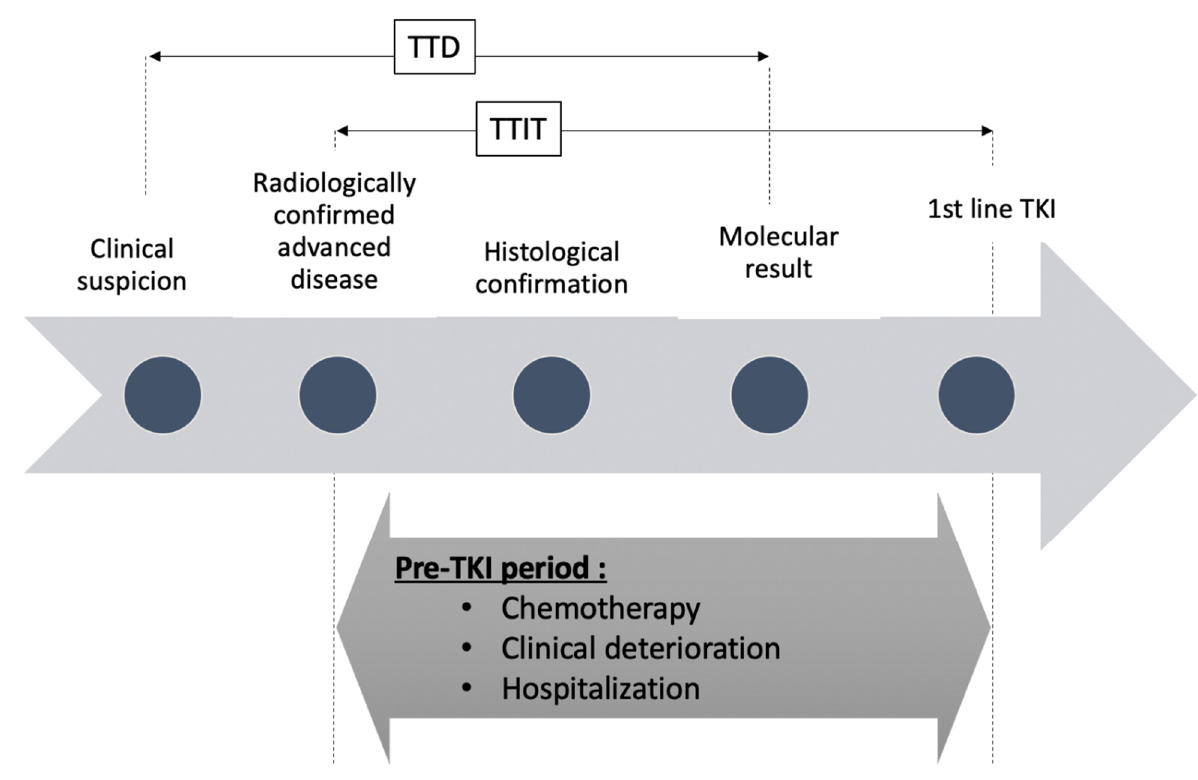
Figure 1. Timeline depicting pre- tyrosine kinase inhibitors (TKI) period for patients with epidermal growth factor receptor (EGFR) mutated NSCLC. TTD = time to detect EGFR mutation. TTIT: time to initiate TKI.